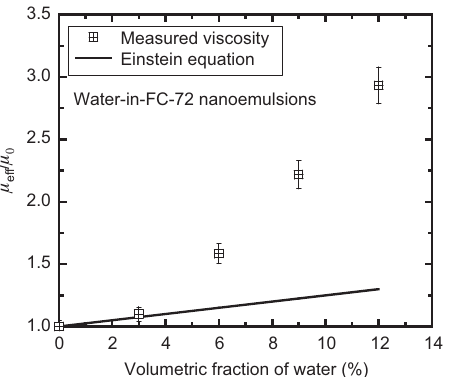
Figure 11 The relative viscosity of water in the FC-72 nanoemul- sions vs. the volumetric fractions of the water nanodroplets. The measurements were conducted at room temperature on a Brookfield